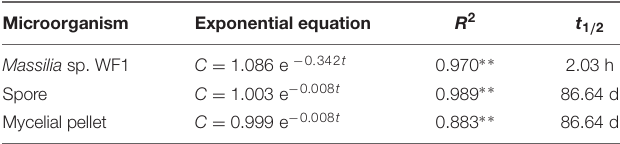
TABLE 1 | First-order kinetics equations and the corresponding half-life times of phenanthrene (PHE) biodegradation by Massilia sp. WF1, spore, and mycelial pellet of Phanerochaete chrysosporium at 28 ◦ C. Microorganism Exponential equation R 2 t 1 / 2 Massilia sp.